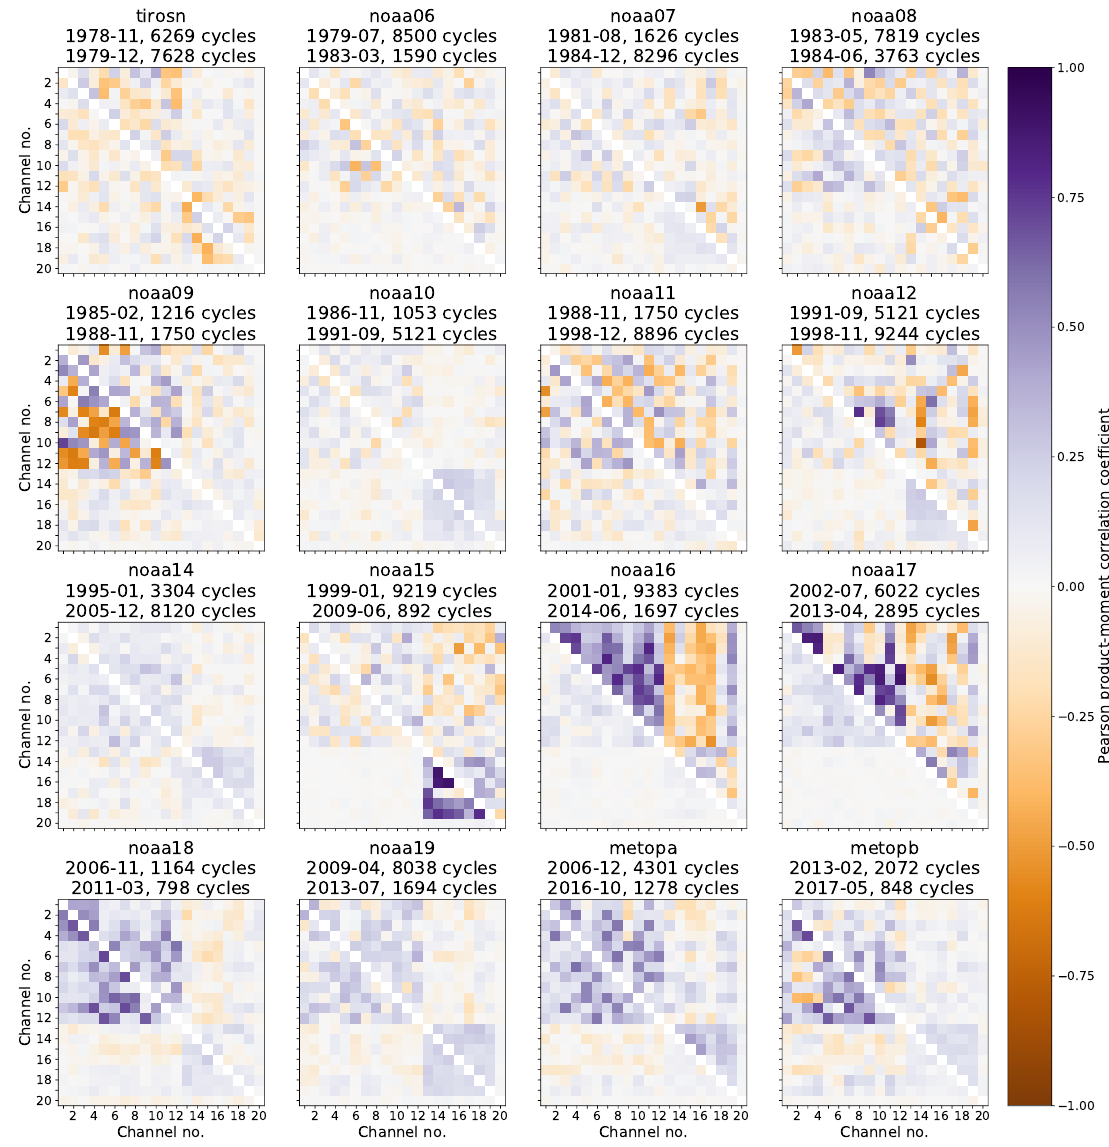
Figure 4. Pearson product-moment correlation between the error in different channels for all HIRS satellites. The lower triangles show correlations during a month early in the sensor life, whereas the upper triangles show the same, but late in the sensor life. Those triangles do not include the diagonal, which includes no information and is indicated as zero, as a reminder that this is not a normal correlation matrix. The title for each panel indicates the number of sets of calibration measurements ( n l in Equation (2)) used to calculate the correlation coefficients, and the month illustrated in the data. To take a closer look at such temporal evolution, Figure 6 shows the noise and error correlation behaviour for NOAA-15 HIRS channel 1 for four days in June 1999, as determined by the 2-sample Allan deviation